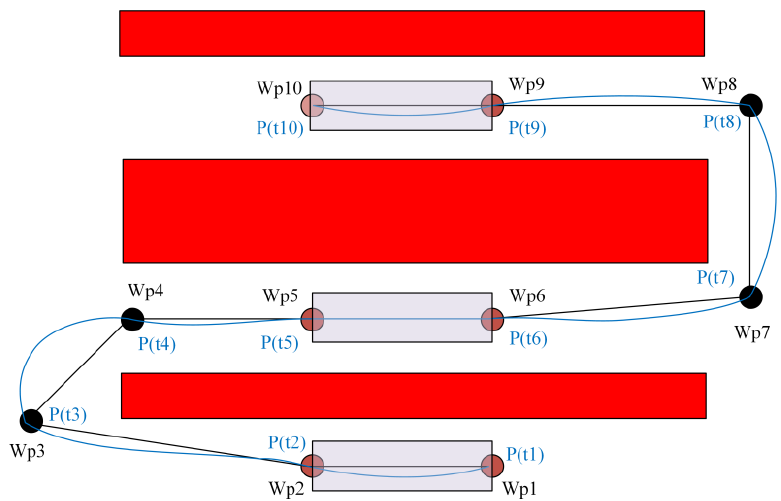
Figure 7. Schematic diagram of constraints in trajectory optimization.